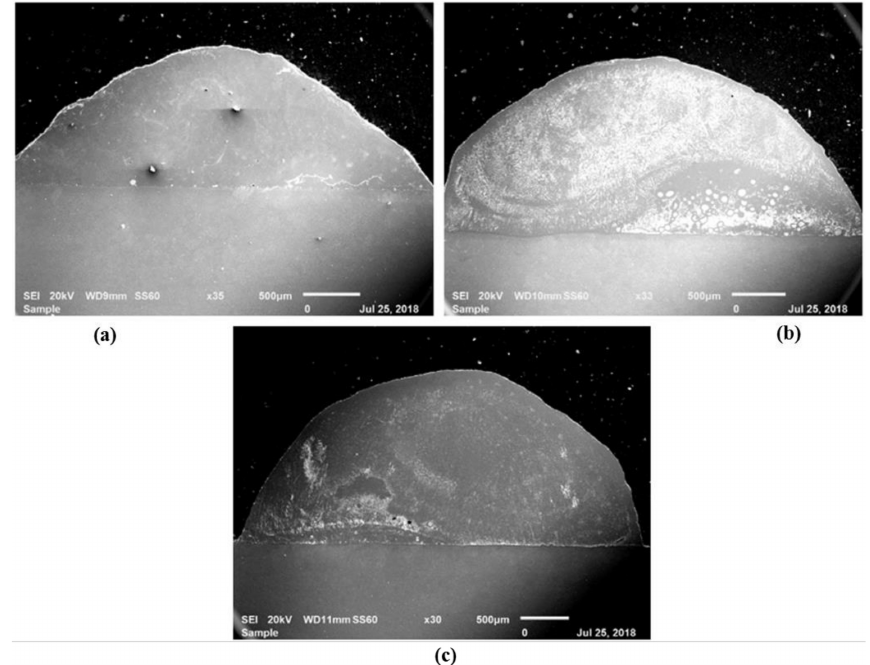
Figure 2. SEM images of the as-built samples: sample 1 ( a ); sample 2 ( b ); and sample 3 ( c ) prior to heat